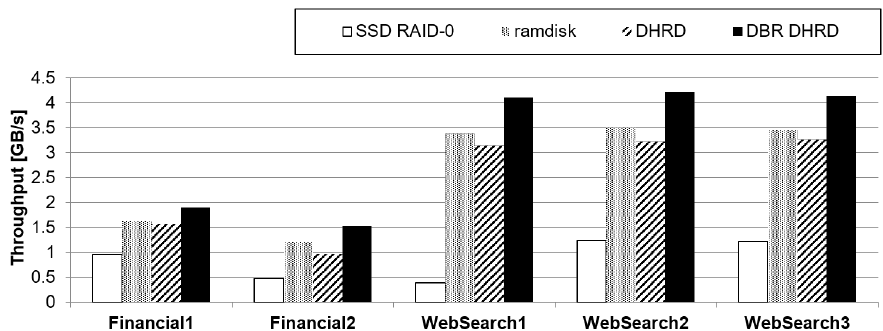
Figure 7. SPC traces: It plots two I/O traces from online transaction processing (OLTP) applications running at two large financial institutions and three I/O traces from a popular search